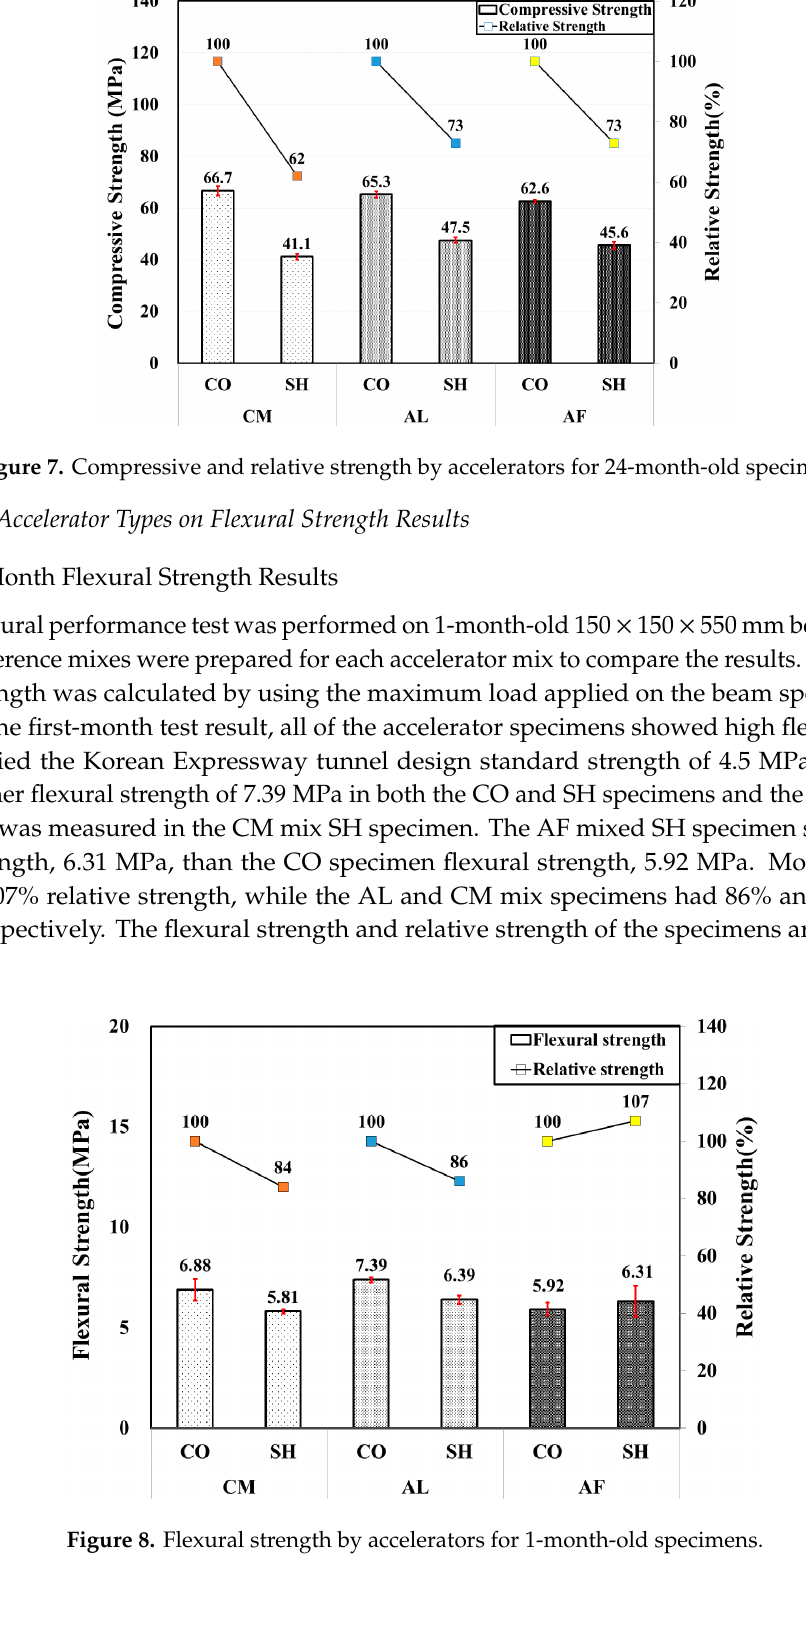
Figure 8. Flexural strength by accelerators for 1-month-old specimens.